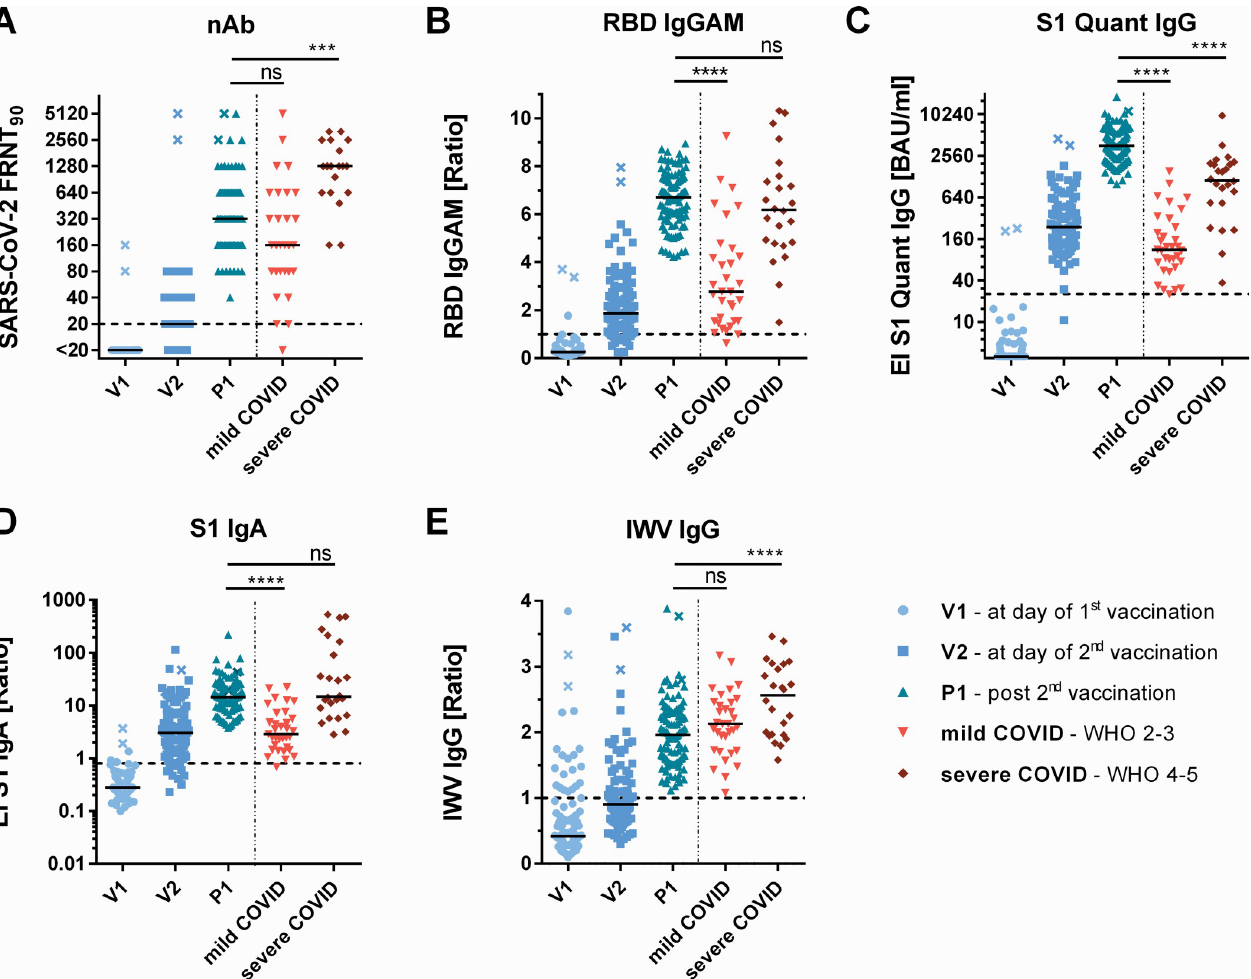
Fig 2. BNT162b2 vaccination induced antibodies in comparison to SARS-CoV-2 infection induced antibodies The presented data shows antibody ratios before first (V1), 3 weeks after first (V2), and 2 weeks after second vaccination (P1), as well as antibodies in sera of patients after mild and severe COVID-19 course. ( A ) Reciprocal titers of SARS-CoV-2 neutralizing antibodies were measured in focus reduction neutralization assay with 90% inhibition (FRNT 90 ). ( B ) RBD IgGAM signals determined as sample/cut-off ratios ( C ) S1 quant IgG antibodies were quantitatively measured in binding antibody units per milliliter (BAU/ml). ( D-E ) S1-IgA and inactivated SARS-CoV-2 whole virus IgG signals (IWV) were determined as sample/calibrator ratios. The horizontal dotted lines represent positivity cut-offs. � = p < 0.05, �� = p < 0.01, ��� = p < 0.001, ���� = p < 0.0001, ns = not significant. x-marked data points represent vaccinees with a previous SARS-CoV-2